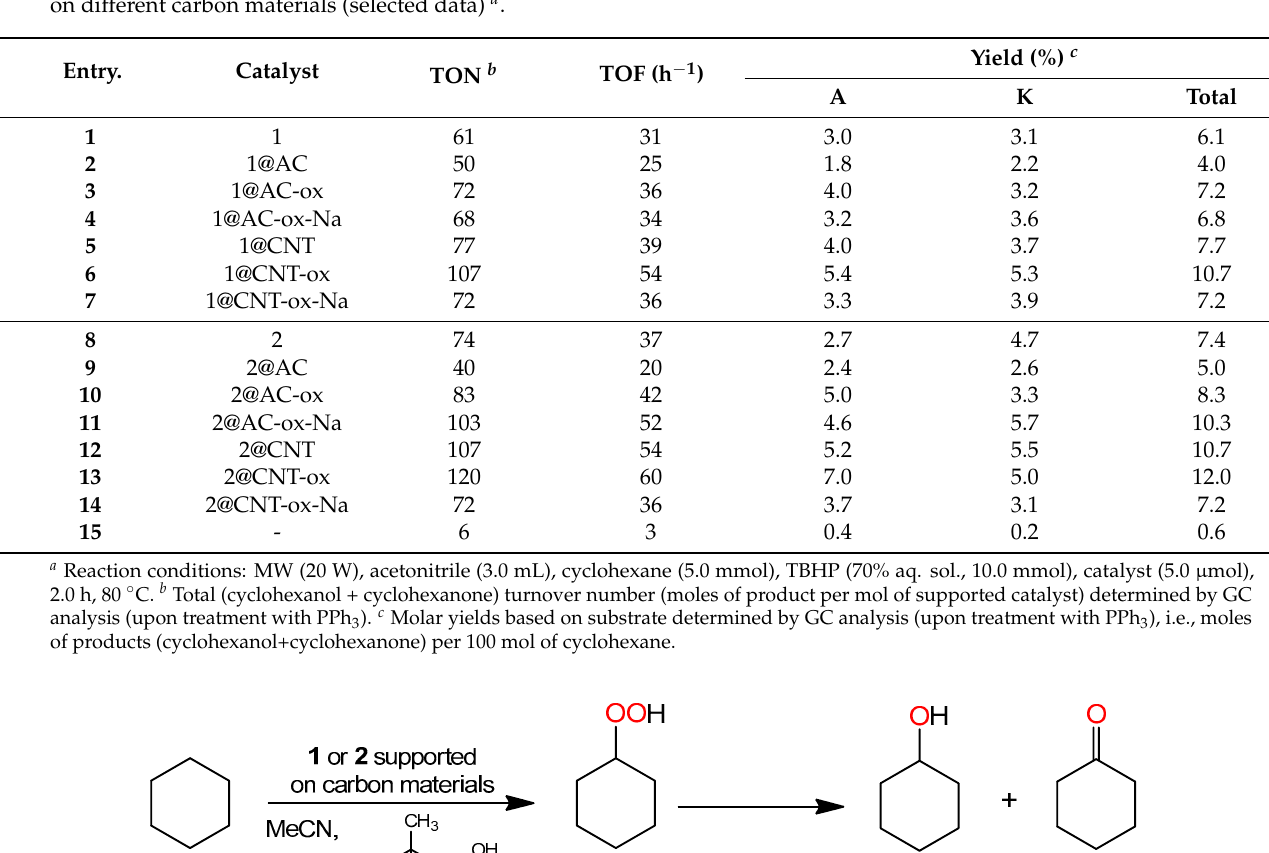
Table 4. MW-assisted catalytic oxidation of cyclohexane with TBHP in MeCN, catalyzed by complexes 1 and 2 supported on different carbon materials (selected data) a .